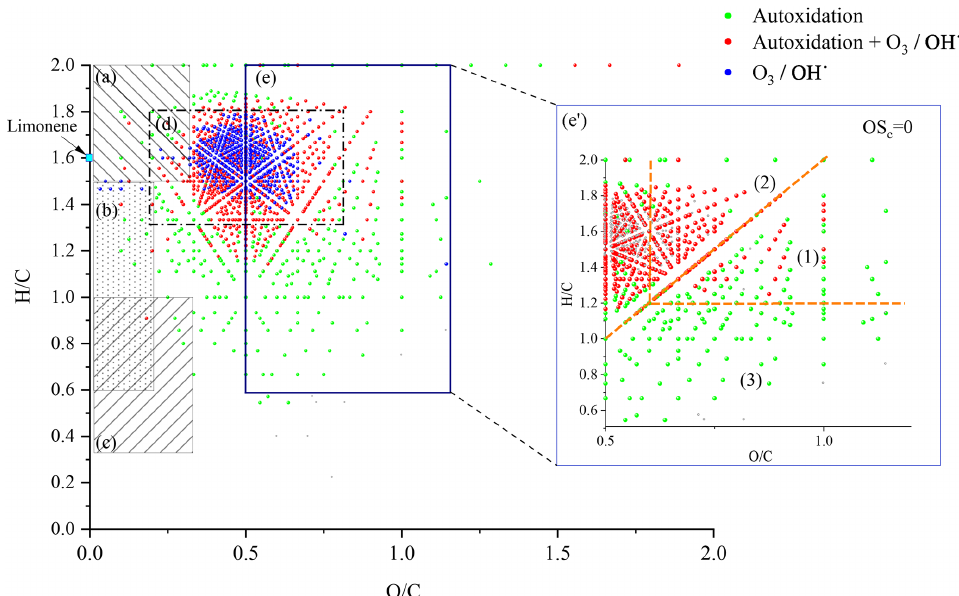
Figure 3. van Krevelen representation of all the chemical products and the different families of chemical compounds described in the litera- ture: (a) aliphatic compounds; (b) unsaturated hydrocarbons; (c) aromatics hydrocarbons; (d) compounds obtained by ozonolysis (including OH-initiated oxidation) (Kundu et al., 2012); (e) HOMs, (e’) HOMs formed without O 3 / OH